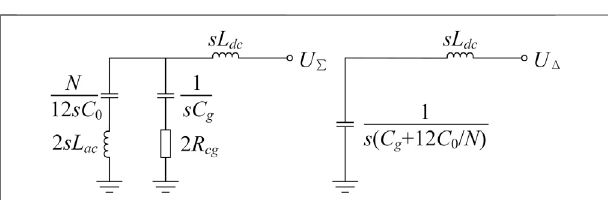
FIGURE 9 | The common-mode (left) and differential-mode (right) models of the converter in case 3.